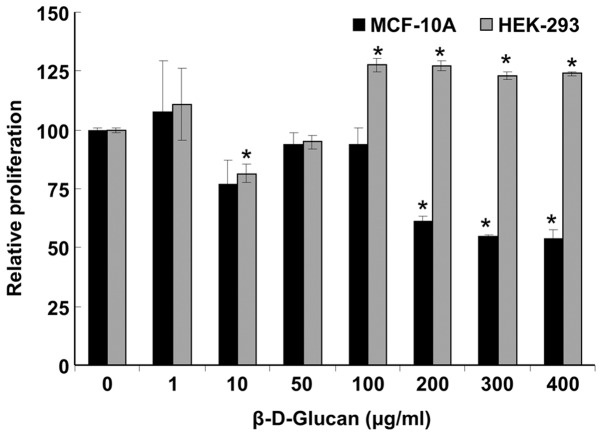
β-D-glucan inhibits MCF-10A but not HEK-293 cell proliferation. MCF-10A and HEK-293 cells were incubated in phenol red-free IMEM + 5% DCC and the indicated concentrations of β-D-glucan dissolved in DMSO for a total of 72 h with a medium/treatment change after 48 h. Values are the BrdU incorporation absorbances normalized to DMSO (zero) and are the mean ± SEM for 4 separate values in one experiment. Values of β-D-glucan in DMSO were corrected for the inhibitory effect of DMSO on cell proliferation. *p<0.05 vs. control (Student’s t-test). The IC50 value for β-D-glucan in MCF-10A cells was 464 μg/ml (calculated in Excel).